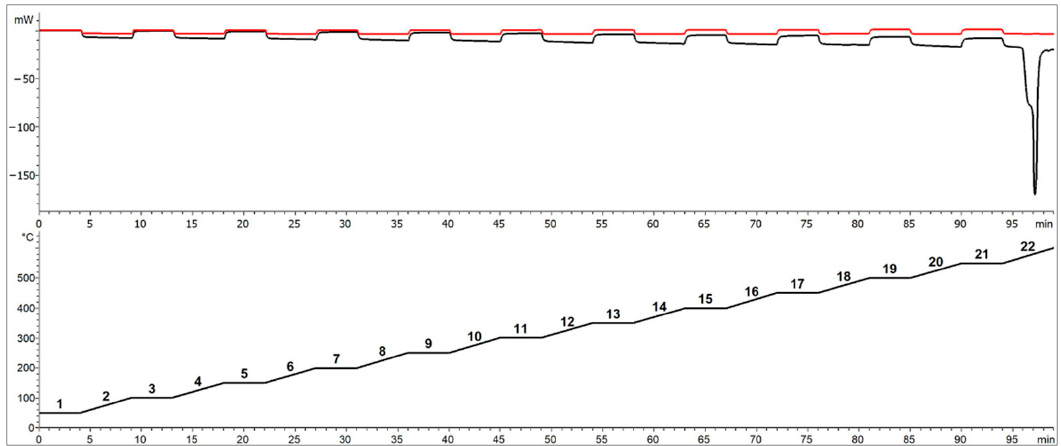
Figure 5. TGA/DSC analysis for cp determination: on the top, respectively, sapphire (red line) and sample (black line) heat flows; on the bottom, the temperature program used, which consists of a series of isotherms and ramps, according to the DIN 51007 protocol.